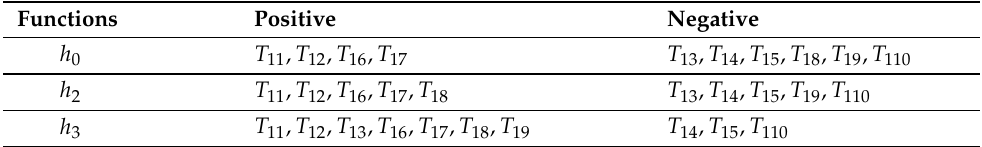
Figure 34. The ten subregions inside the region T 1 of the Poincaré ball. Table 12. Signs of functions h 0 , h 2 and h 3 in the subregion of T 1